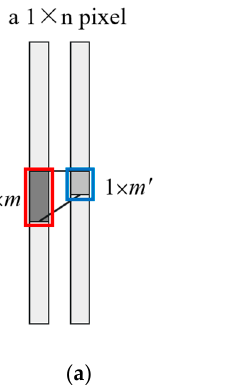
Figure 1. ( a ) A typical 1D convolution; ( b ) 1D ‐ CNN classification framework in [24]. In this framework, there are several layers: 1D convolutional layer, pooling layer, fully ‐ connected (FC) layer, and an output layer. CNN: convolutional neural network.